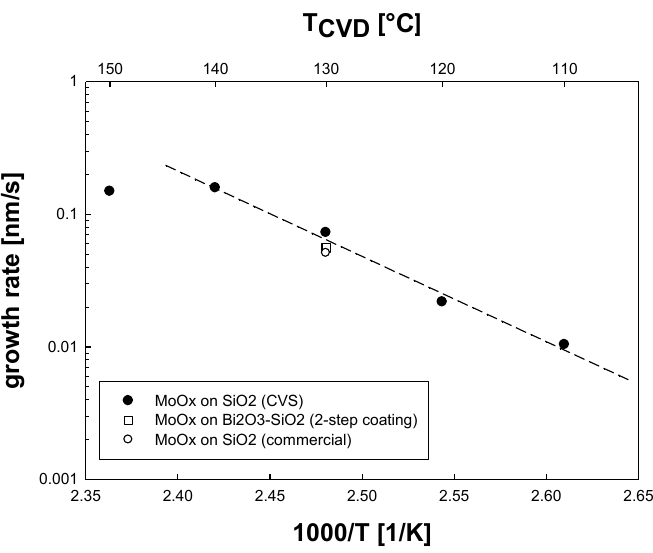
Figure 2. Arrhenius plot for CVD based growth rates of molybdenum oxide films on silica particles generated freshly by CVS (black dots), silica particles generated by CVS and coated with an additional layer of bismuth oxide (open square), and commercially available silica particles (open dot). The dashed line fit was used to derive the activation